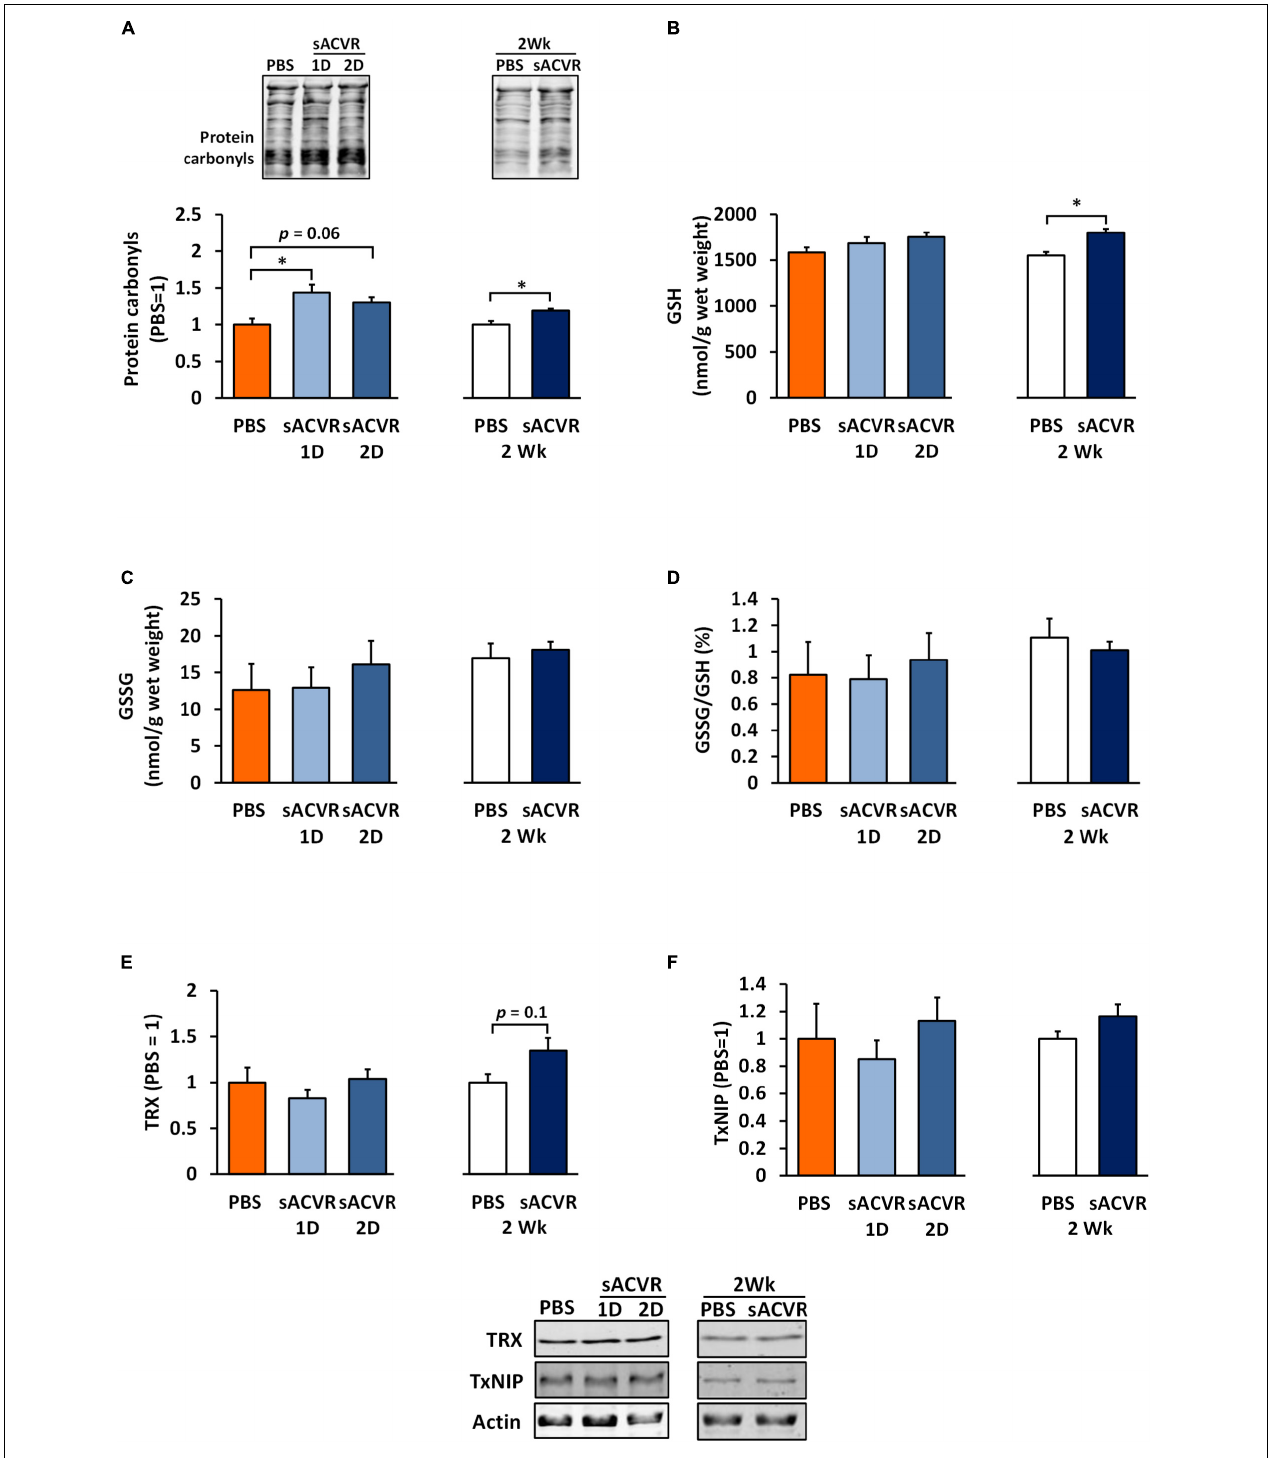
FIGURE 3 | Redox-balance markers in healthy skeletal muscle in mice that were administered with soluble activin receptor type 2B (sACVR) or vehicle (PBS). Muscles were collected 1 or 2 days after a single sACVR administration or after 2 weeks of administration. (A) Protein carbonyls, (B) reduced glutathione (GSH), (C) oxidized glutathione (GSSG), (D) ratio of oxidized glutathione to reduced glutathione (GSSG/GSH), (E) TRX protein, (F) TxNIP protein; n = 5–6 in all groups except n = 8–11 in sACVR 2 Wk group. The symbol ∗ depicts statistical significance p < 0.05. Data is expressed as means ± SE. Representative blots were cropped from the original blot images ( Supplementary Figure 7 ). Representative blots of TRX and TxNIP share the same IDs and were analyzed in the same run and are thus aligned on top of each other and share the same representative control blot (actin). Protein carbonyls were normalized to total protein loading.